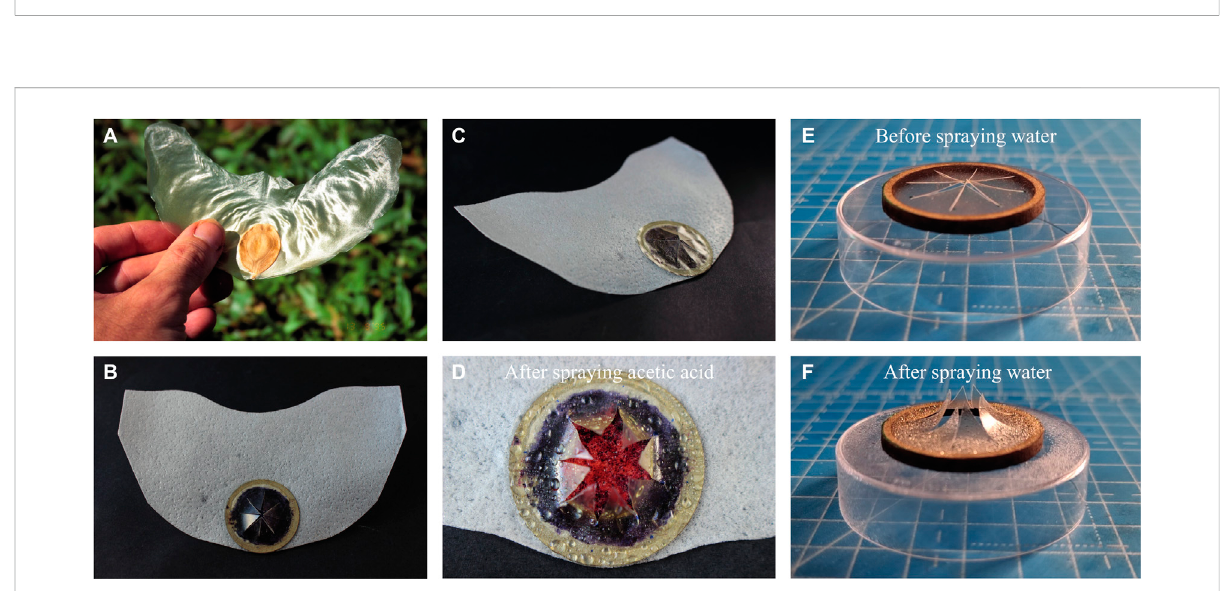
FIGURE 10 Javan cucumber seed glider template, the manufactured prototypes and the integrated actuators. (A) gives an image of an Alsomitra macrocarpa seed(CCby2.0,photobyScottZona)thatwasusedasatemplatefortheglider, (B) showsthetopviewofonefabricatedprototypewith anintegratedsensinglayerandactuator, (C) showsthesameprototypefromasideviewvisualizingthe3Dshapeofthewing, (D) givesadetailedview of the actuator and sensor after it was sprayed with acetic acid, (E) illustrates an actuator made from CNF:G — 0.25:0.75 fi lms before it was manually sprayed with water and, (F) shows the same actuator after its been sprayed with